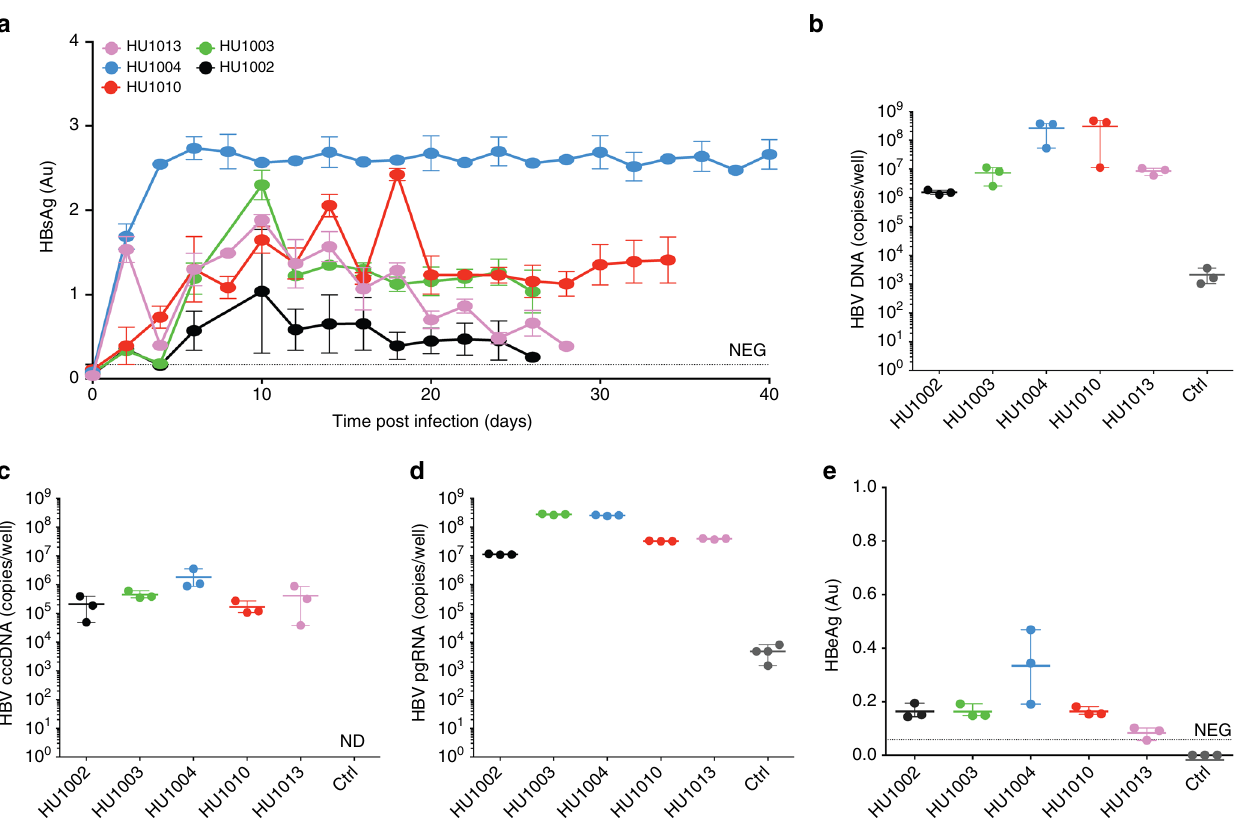
Fig. 2 Persistent HBV infection in single donor PHH co-cultures. Assessment of HBVcc infection of single donor SACC-PHH co-cultures. Quanti fi cation of HBsAg concentrations in the supernatants a , and total HBV DNA b , cccDNA c , pgRNA d in SACC-PHH lysates. e HBeAg was quanti fi ed in the supernatants (day 16 post infection) by HBeAg ELISA. For all HBVcc infections of single PHH donors three to fi ve biological replicates were performed. All data are presented as means ±